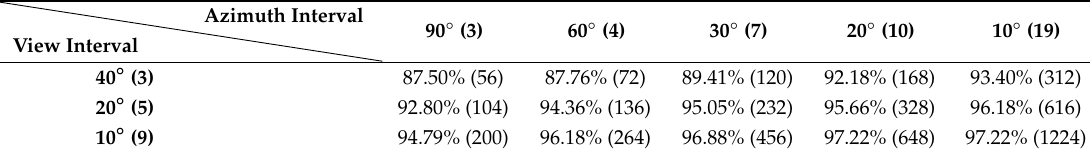
Table 2. Recognition rates on di ff erent training sample